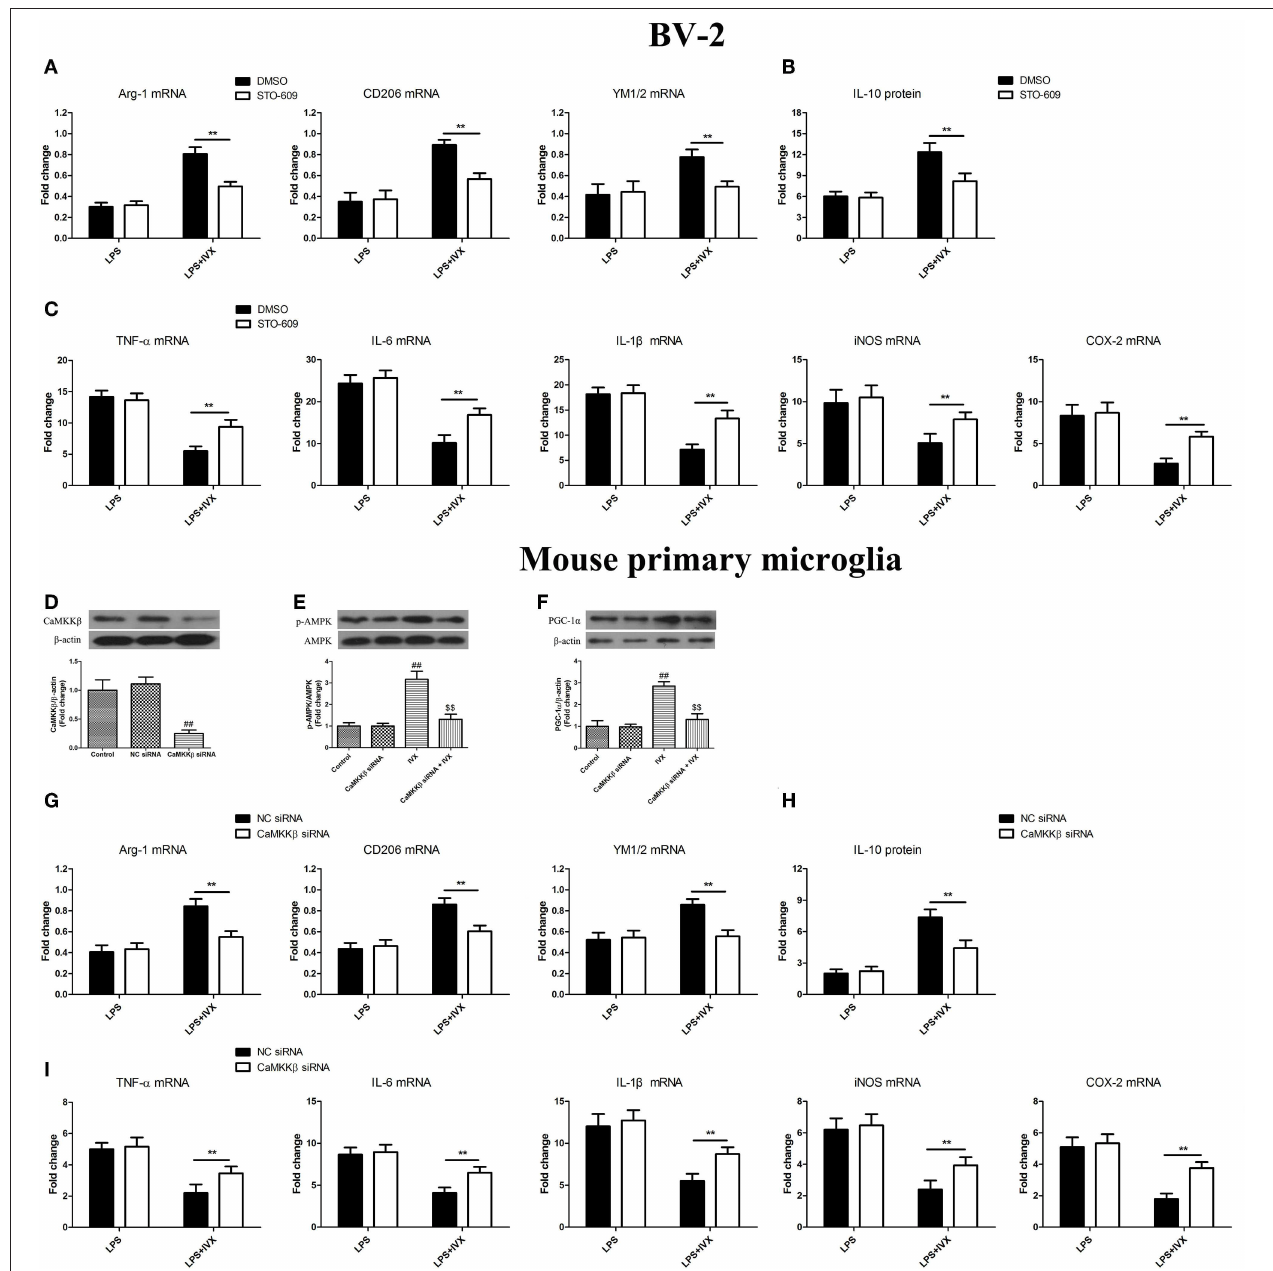
FIGURE 6 | CaMKK β activation is involved in IVX-mediated microglial polarization in BV-2 cells and mouse primary microglia. (D) After treatment with CaMKK β siRNA for 24h and then IVX for 2h in mouse primary microglia, the protein expression of CaMKK β was measured with Western blotting. (E) After treated with CaMKK β siRNA for 24h, mouse primary microglia were exposed to IVX for 1h. The protein expression of p-AMPK was detected by Western blotting. (F) After treated with CaMKK β siRNA for 24h, mouse primary microglia were exposed to IVX for 3h. The protein expression of PGC-1 α was detected by Western blotting. Following pretreatment with 10 µ M STO-609 for 4h and CaMKK β siRNA for 24h, cells were treated with IVX (200 µ g/mL) for 2h and then stimulated with LPS (100ng/mL) for 6h. (B,H) The mRNA expression of M2 microglial markers (Arg-1, CD206, and YM1/2) were detected via RT-PCR. (C,I) The mRNA expression of M1 microglial markers (TNF- α , IL-6, IL-1 β , iNOS, and COX-2) were detected via RT-PCR. Pretreatment with 10 µ M STO-609 for 4h and CaMKK β siRNA for 24h, cells were treated with IVX (200 µ g/mL) for 2h and then stimulated with LPS (100ng/mL) for 24h. (C,G) The release of IL-10 was measured with ELISA. The experiments were conducted in triplicate and repeated at least three times. Values are expressed as mean ± SEM ( n = 4 in each group). ## p < 0.01, vs. control group; $$ p < 0.01 vs. IVX group; ** p < 0.01, STO-609 or CaMKK β siRNA + LPS + IVX group vs. LPS + IVX group.